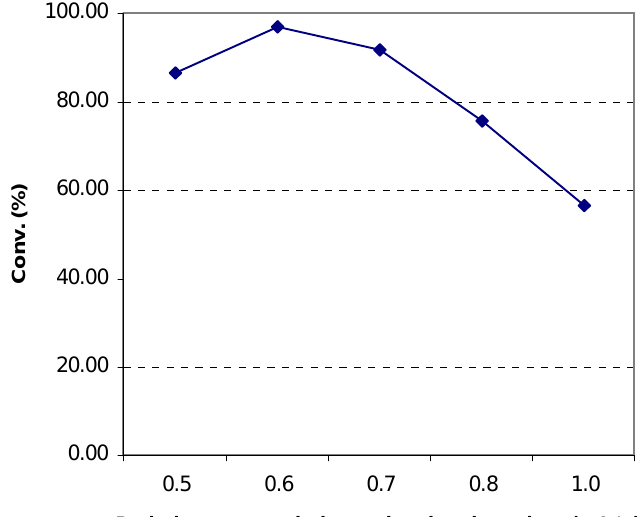
O : 40 mmol, 5.8 2 3